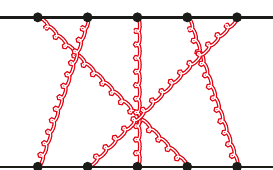
Figure 9. An example of an entangled colour configuration. This specific one is the first term of d 1 in eq.